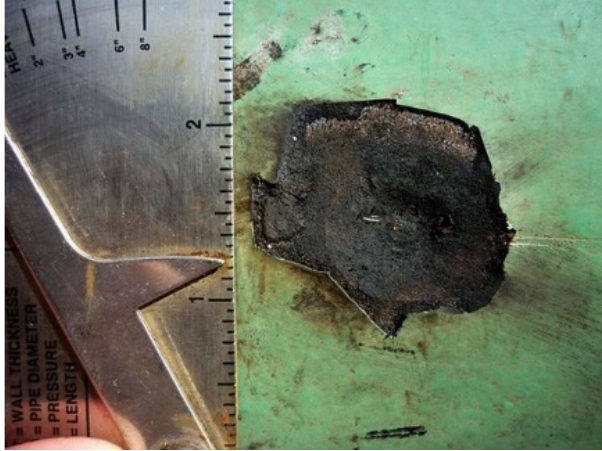
Figure 1. Pitting corrosion on a pipeline.